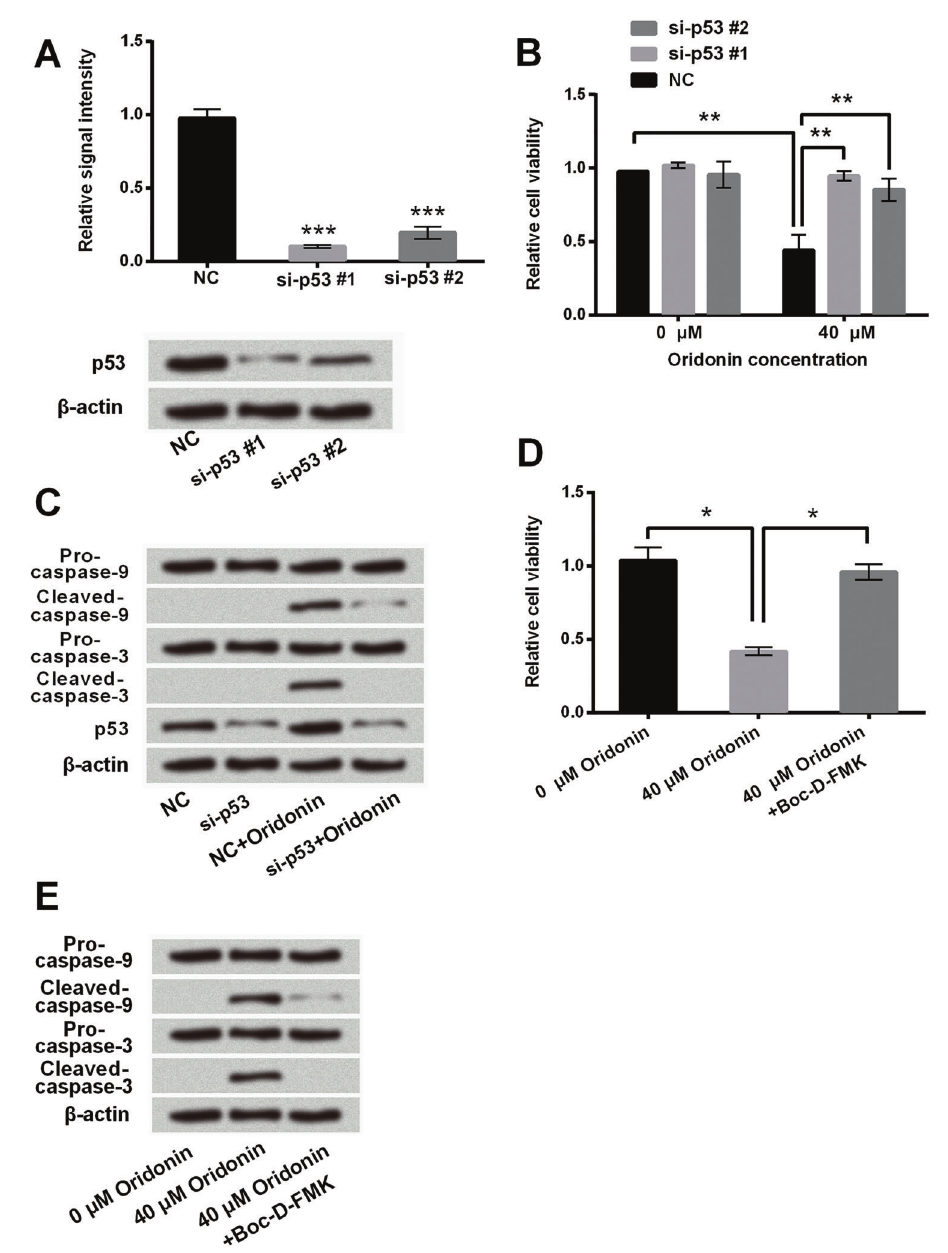
Figure 7. Role of p53 and caspase in the anti-tumor effect of oridonin. SNU-216 cells were transfected with si-p53 #1 or si-p53 #2. A , Transfected ef fi ciency was veri fi ed by western blot. SNU-216 cells were transfected with si-p53 #1 or si-p53 #2, and then the transfected cells were exposed to oridonin (40 m M) for 24 h. B , Cell viability was measured by CCK-8 assay. C , Expression of p53, cleaved-caspase-3, and cleaved-caspase-9 was determined by western blot. SNU-216 cells were incubated with oridonin (40 m M) or combined with caspase inhibitor, Boc-D-FMK. D , Cell viability and E , expression of cleaved-caspase-3 and cleaved-caspase-9 were measured by CCK-8 assay and western blot, respectively. NC, negative control of si-p53 #1 and si-p53 #2. Data are reported as means ± SD. *P o 0.05, **P o 0.01, ***P o 0.001